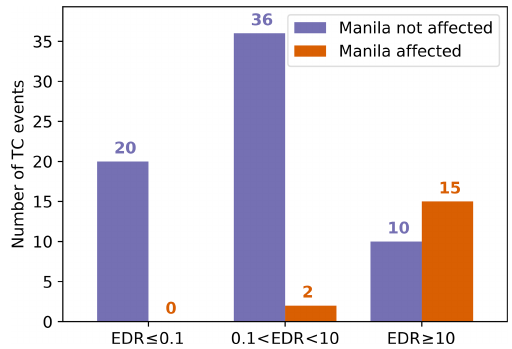
Figure 8. Distribution of the event damage ratios (EDRs) for 83 TCs making landfall in the Philippines from 1980 to 2017. The number of events for three ranges of EDRs are compared, differ- entiating whether Manila was directly affected by the TC’s wind field (orange) or not (purple). Manila is considered to be affected if the hazard intensity exceeds 25ms − 1 at 14.5 ◦ N, 121.0 ◦